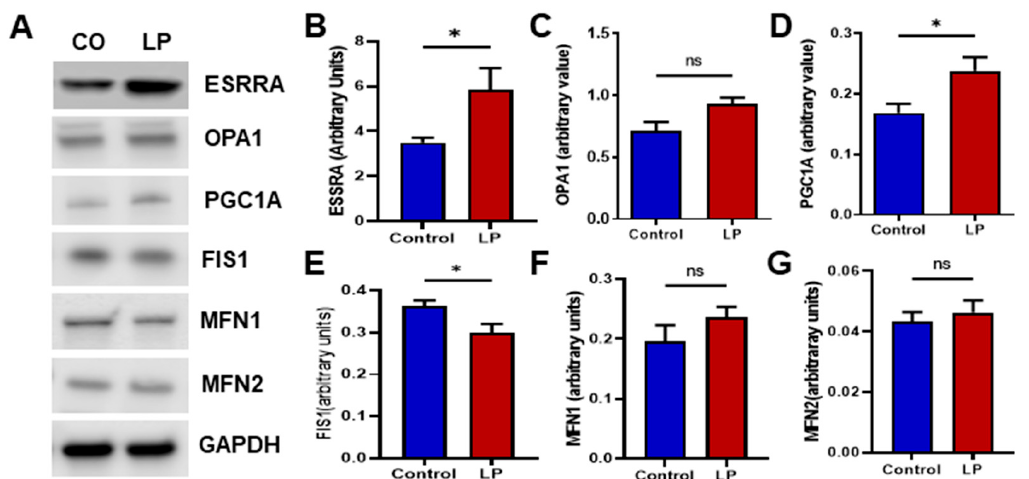
Figure 5. Effects of LP programming on the expression of the genes involved in mitochondrial dy- namics and biogenesis in the liver of the control and LP rats. The mRNA levels of mitochondrial dynamic genes: ( A ) Opa1; ( B ) Mfn1; ( C ) Mfn2; ( D ) Fis1; ( E ) Pgc1a ( F ) Pgc1b, ( G ) Erra; ( H ) Nrf2; ( I ) Nrf1; ( J ) Drp1 are analyzed by qPCR. The mRNA expressions of each gene are normalized to the Cyclophilin A expression. Data represent mean ± SEM (* p < 0.05, ** p < 0.01, ns—not significant); n = 8.